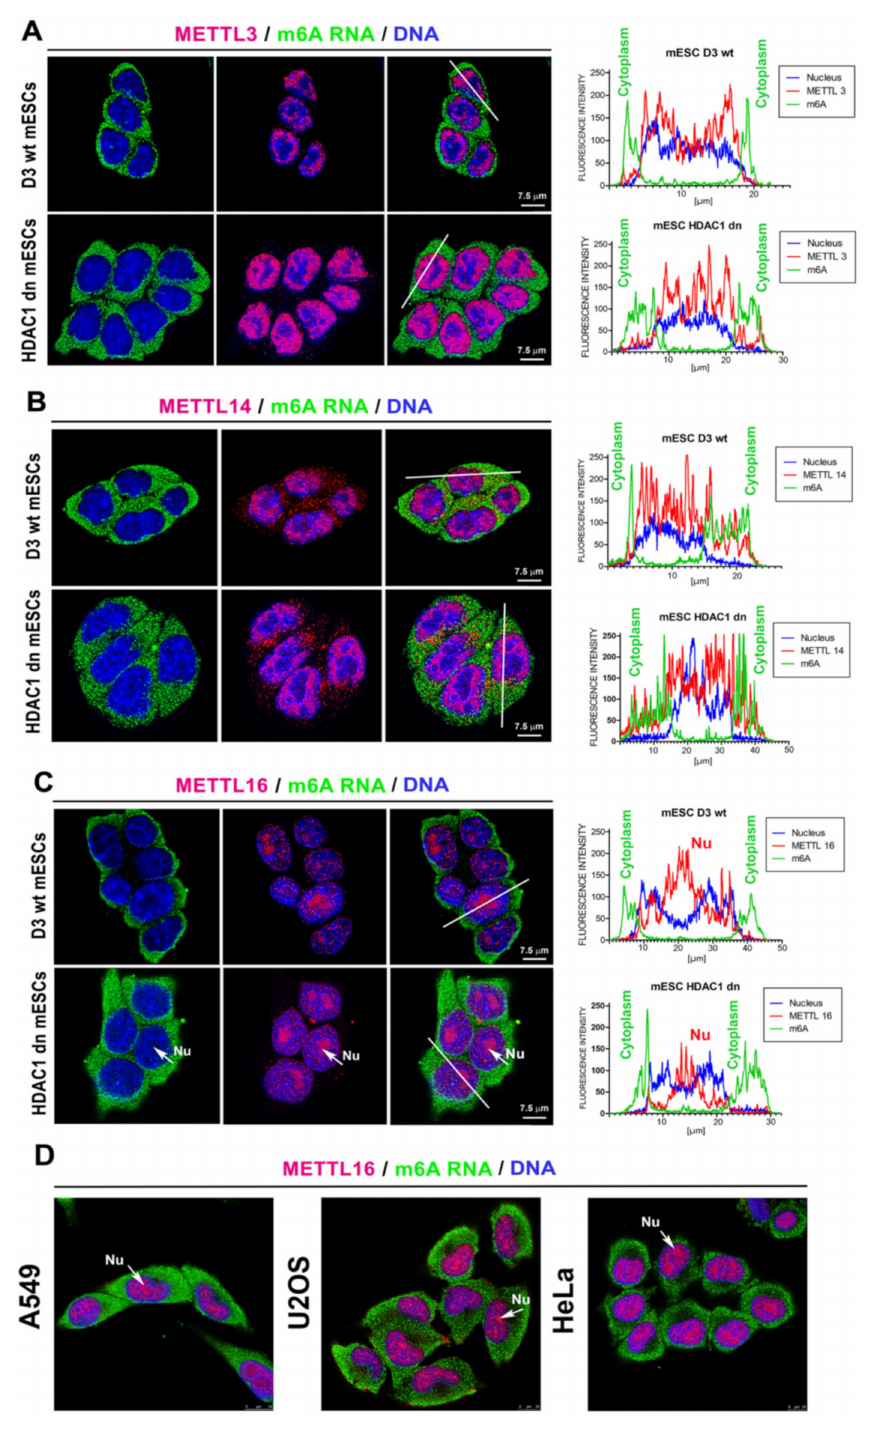
Figure 7. Localization of METTL-like proteins (red) and m6A RNAs (green) in HDAC1 wt and HDAC1 dn mESCs. The analysis was performed for ( A ) METTL3 (red), and m6A RNAs (green), ( B ) METTL14 (red) and m6A RNAs (green), or ( C ) METTL16 (red) and m6A RNAs (green). ( D ) For comparison with mESCs, the distribution pattern of the METTL16 protein was also analyzed in human tumor cells, A549, HeLa, and U2OS. Scale bars show 7.5 µ m. Experiments were repeated twice; at least 200 cell nuclei were analyzed for each experimental